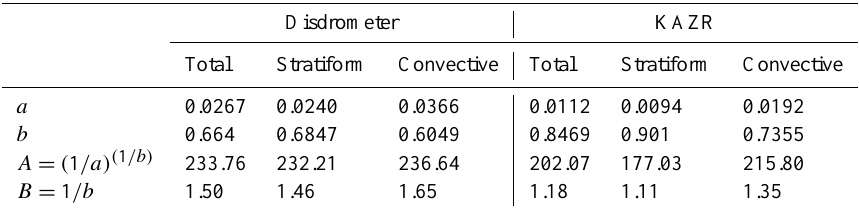
Table 3. Coefficients ( a , A ) and exponents ( b , B ) in Z – R relations derived from disdrometer and the KAZR for convective and stratiform rain